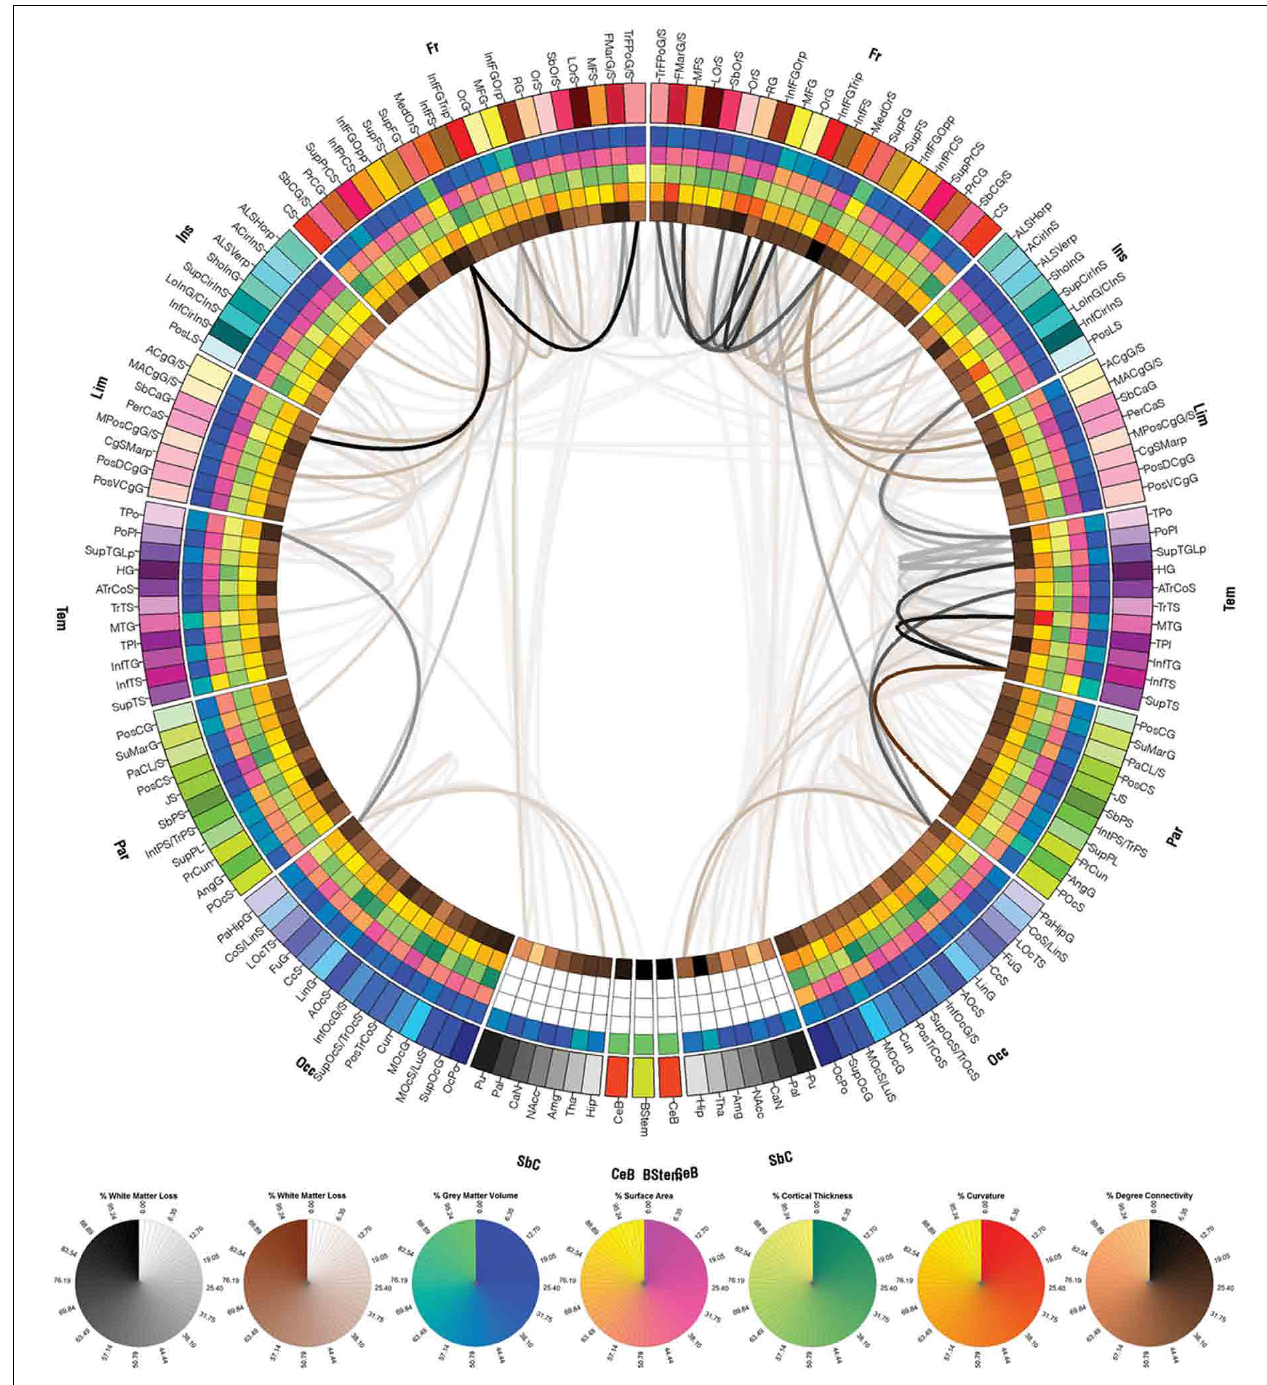
FIGURE 5 |As in Figure 4, for patient